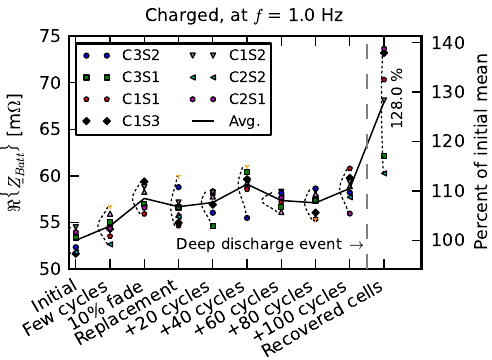
Figure 14. Real part of the impedance at f = 1 Hz at different stages of aging of early life failure pack (Scenario